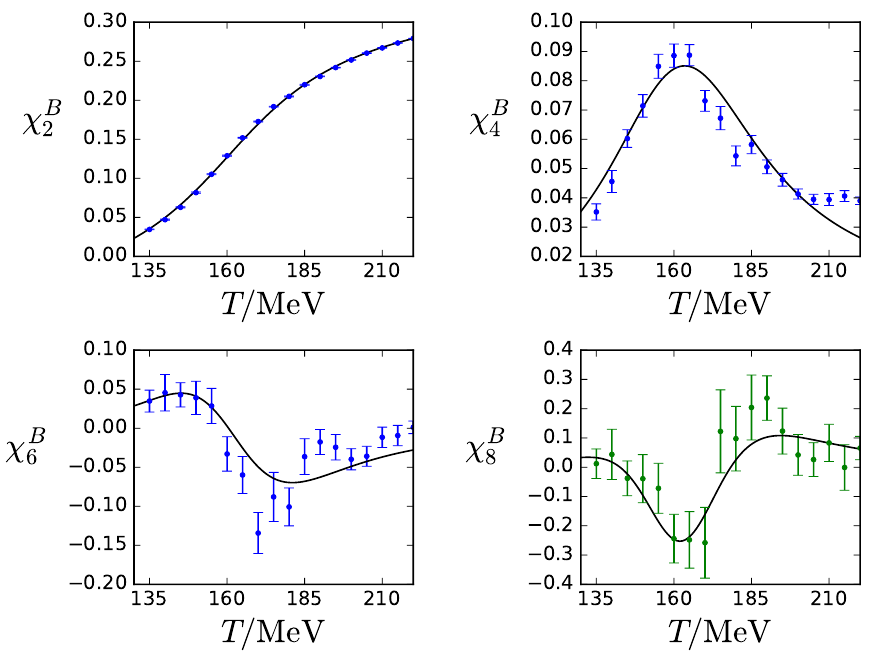
Figure 4 . Results for (cid:31) B together with the result of the toy model of section 3.2. The toy model reproduces much of the features of the lattice